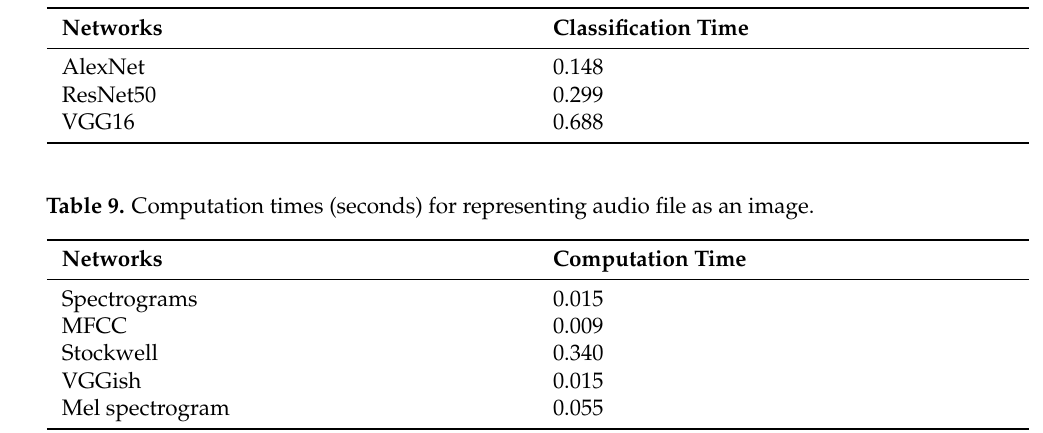
Table 8. Classification time (seconds) for a batch of 100 spectrograms.